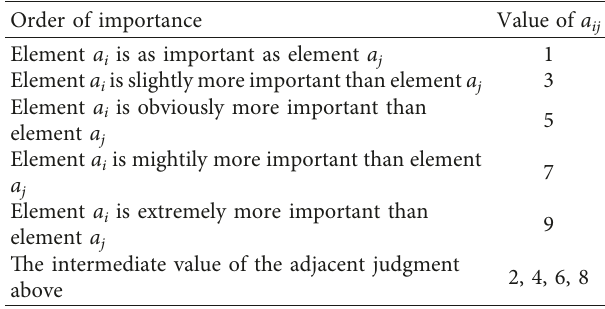
Figure 3: Production planning and optimizing process of enterprise A in cloud manufacturing environment. Table 2: Scale value of decision judgment matrix.